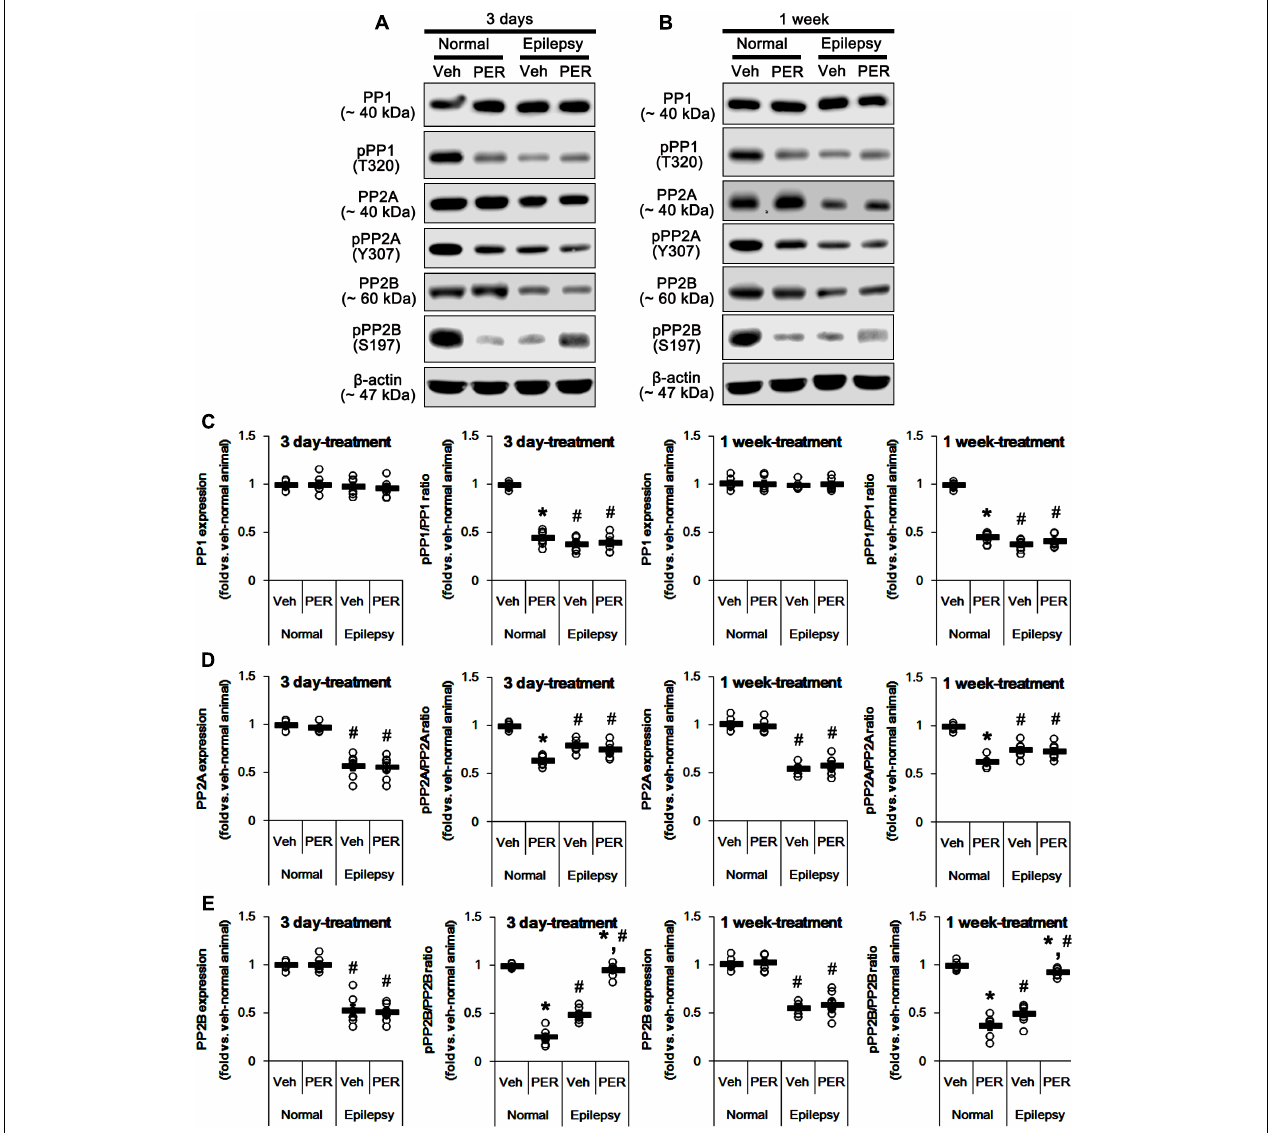
FIGURE 10 | Effects of perampanel on PP1, PP2A, and PP2B expressions and their phosphorylations. (A,B) Representative images for western blot of PP1, phospho (p)-PP1, PP2A, pPP2A, PP2B, and pPP2B in the hippocampal tissues obtained from 3-days (A) and 1-week treated groups (B) . (C–E) Quantifications of PP1, pPP1 (C) , PP2A, pPP2A (D) , PP2B, and pPP2B (E) levels in 3-days and 1-week treated groups. Open circles indicate each individual value. Horizontal bars indicate mean value. Error bars indicate SEM ( ∗ , # p < 0.05 vs. vehicle-treated animals and normal animals, respectively; n = 7,